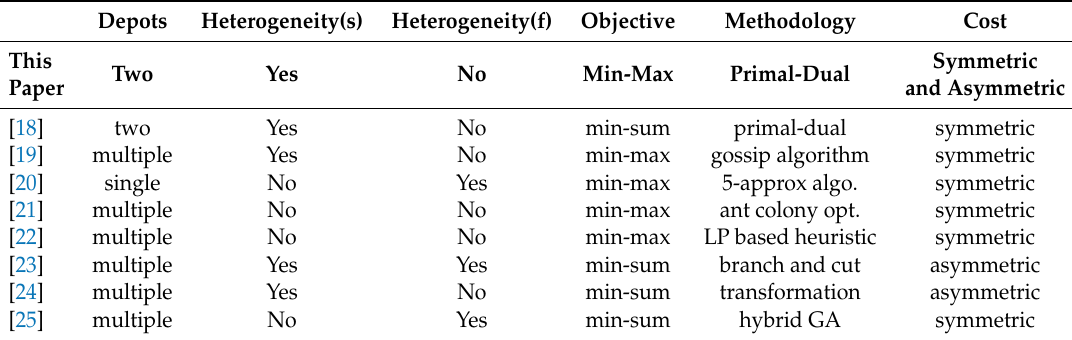
Table 1. An overview of the literature of related